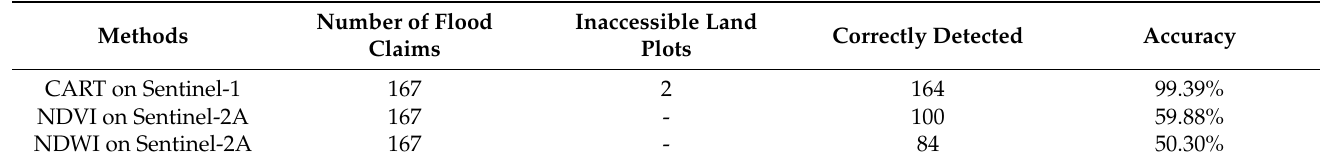
Table 3. Accuracy assessment using verified mobile images of flood detection obtained from CART, NDVI and NDWI methods for land plots unaffected by cloud in Sentinel-2A images.